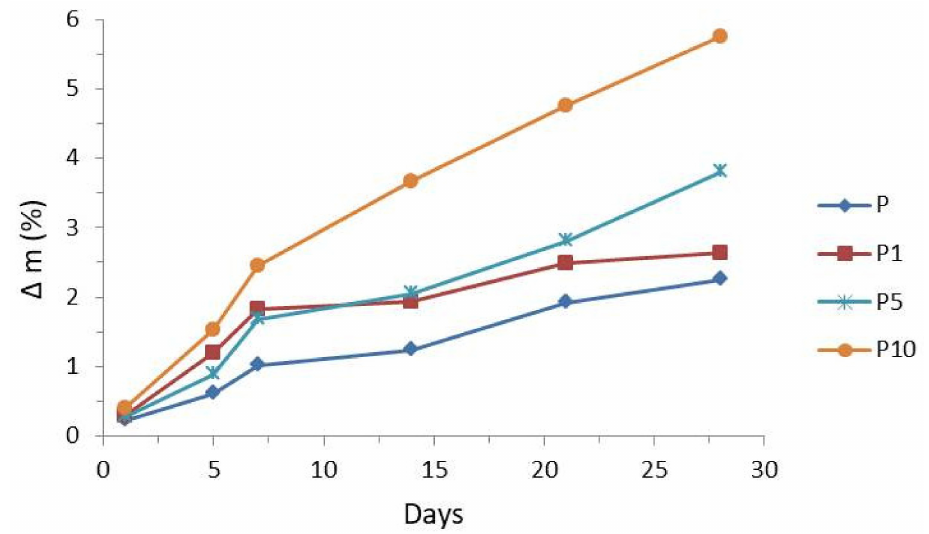
Figure 9. Effects of proteinase K on the degradation rates of samples P, P1, P5, and